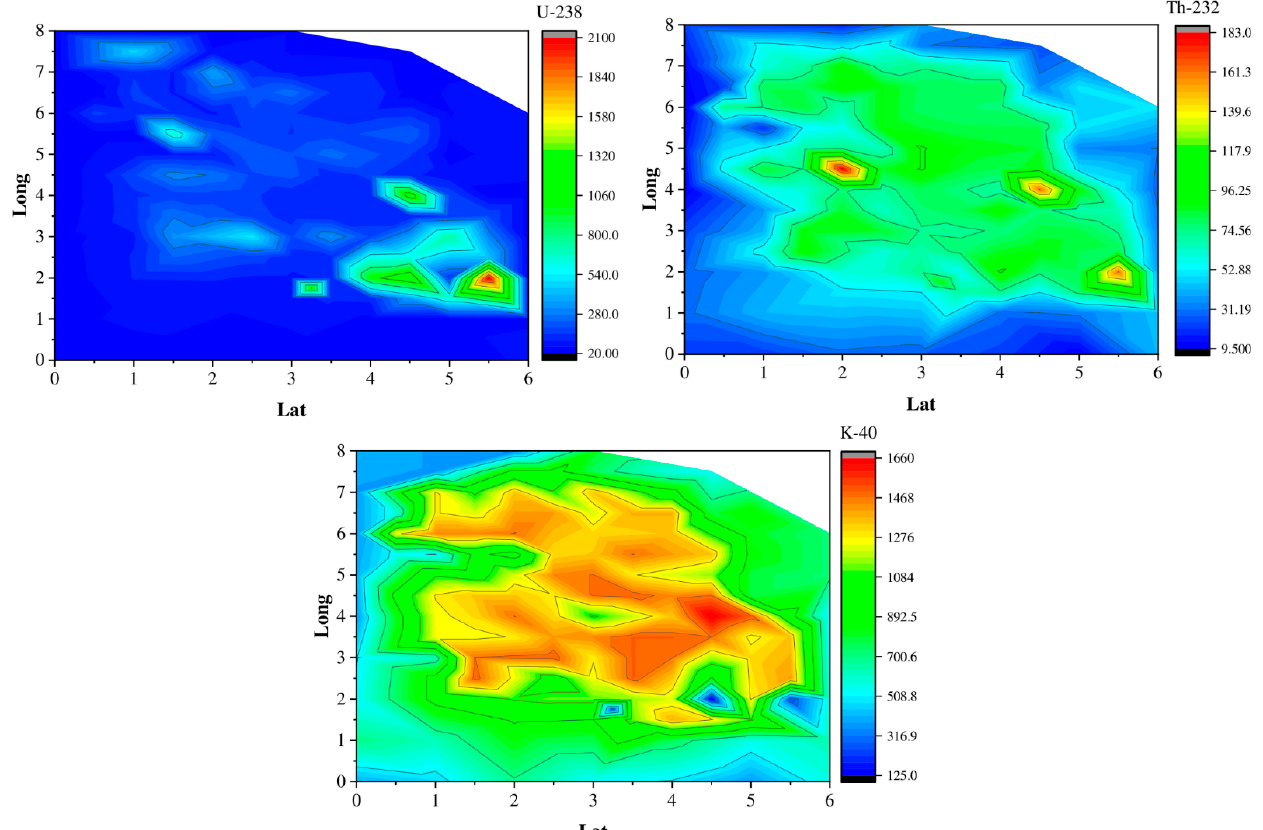
Figure 5. The distribution map of the accumulation of high concentrations of 238 U, 232 Th, and 40 K of the muscovite granites in the investigated area.